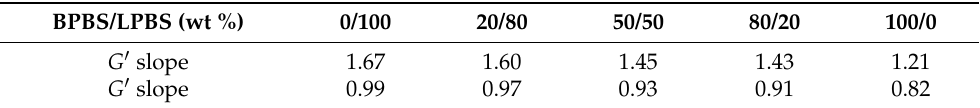
Table 4. Slopes (power law exponents) of storage and loss moduli for BPBS, LPBS and their blends at 150 ◦ C.